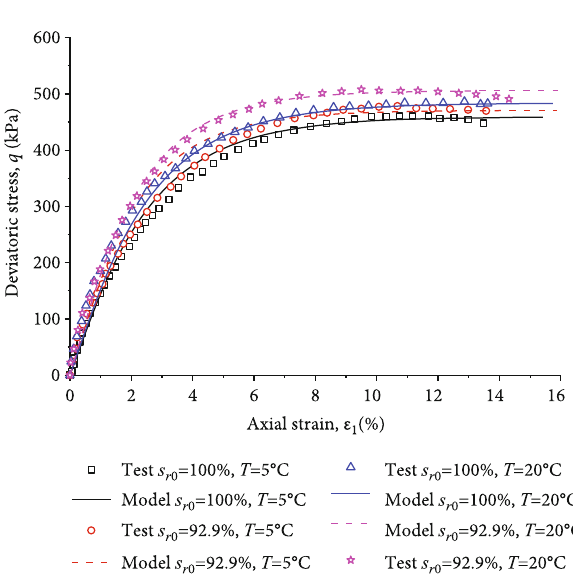
Figure 2: Simulation of stress-strain relationships of drained shear of gassy sand at di ff erent temperatures (test data after Wang et al.